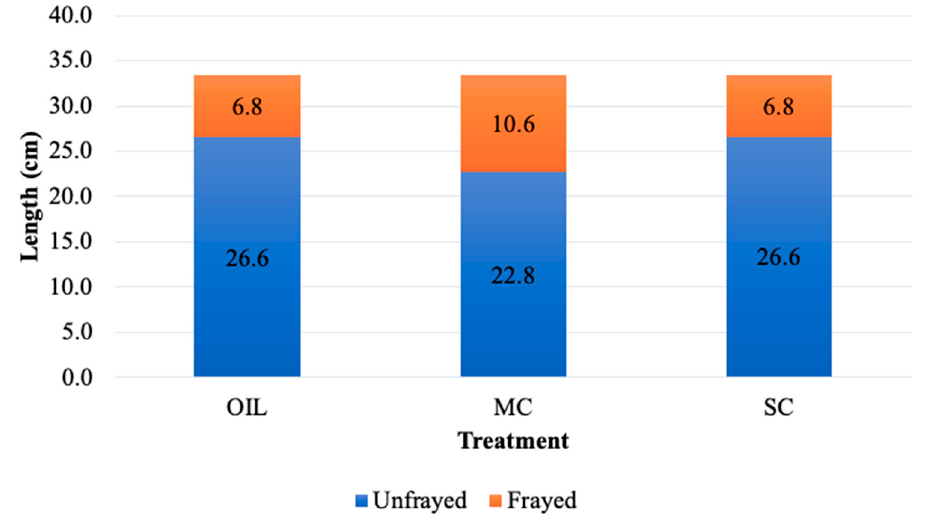
Figure 6. Descriptive measures of environmental enrichment rope length after removal from the farrowing stall 24 h after placement. The total rope length consisted of frayed and unfrayed sections. Ropes were dipped in one of three treatments: OIL = sunflower oil, MC = milky cheese, and SC = semiochemical.